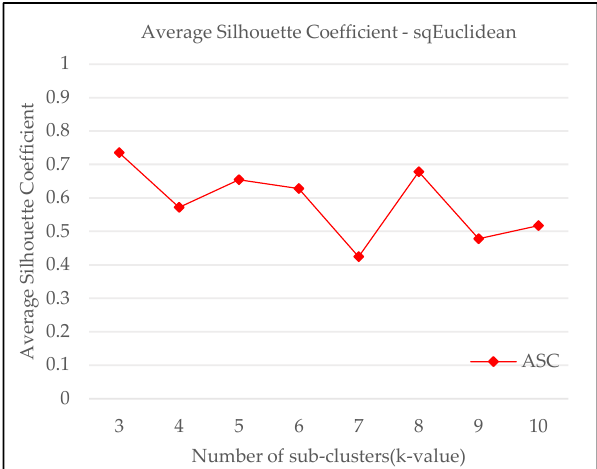
Figure 2. Average Silhouette Coefficient curve.